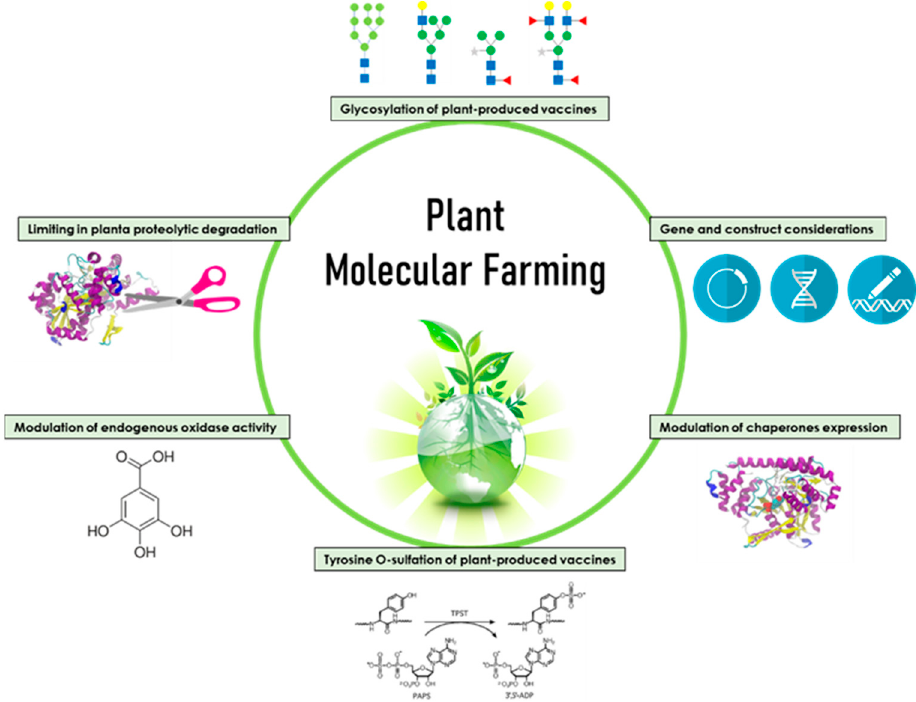
Figure 1. Engineering approaches in plant molecular farming.